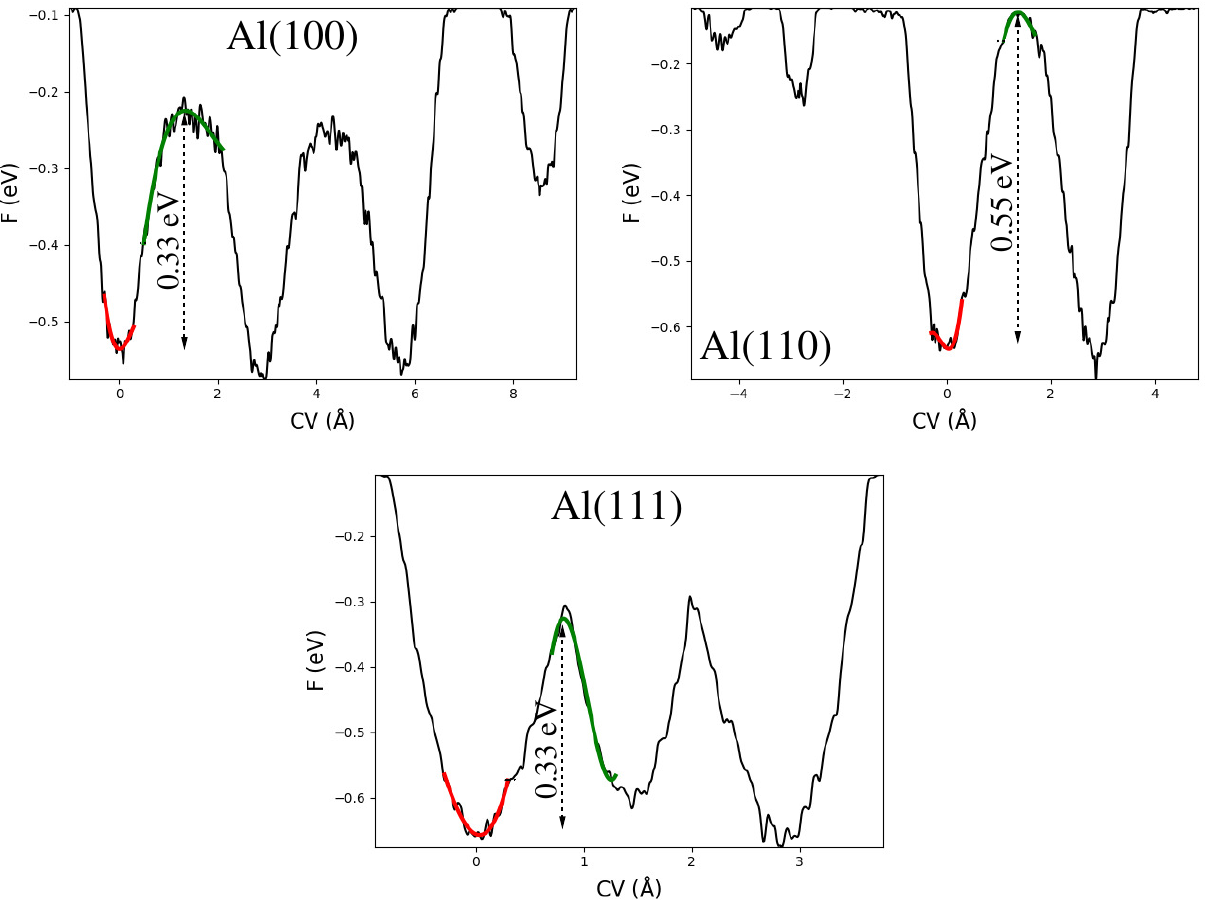
Figure 4. The free energy barriers on the reconstructed Al(100), Al(110), and Al(111) slabs having a surface vacancy. All energy values are in eV and all distance values are in